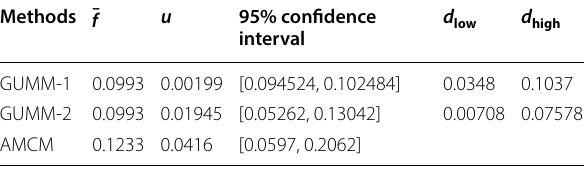
Table 7 Uncertainty evaluation results in experiment